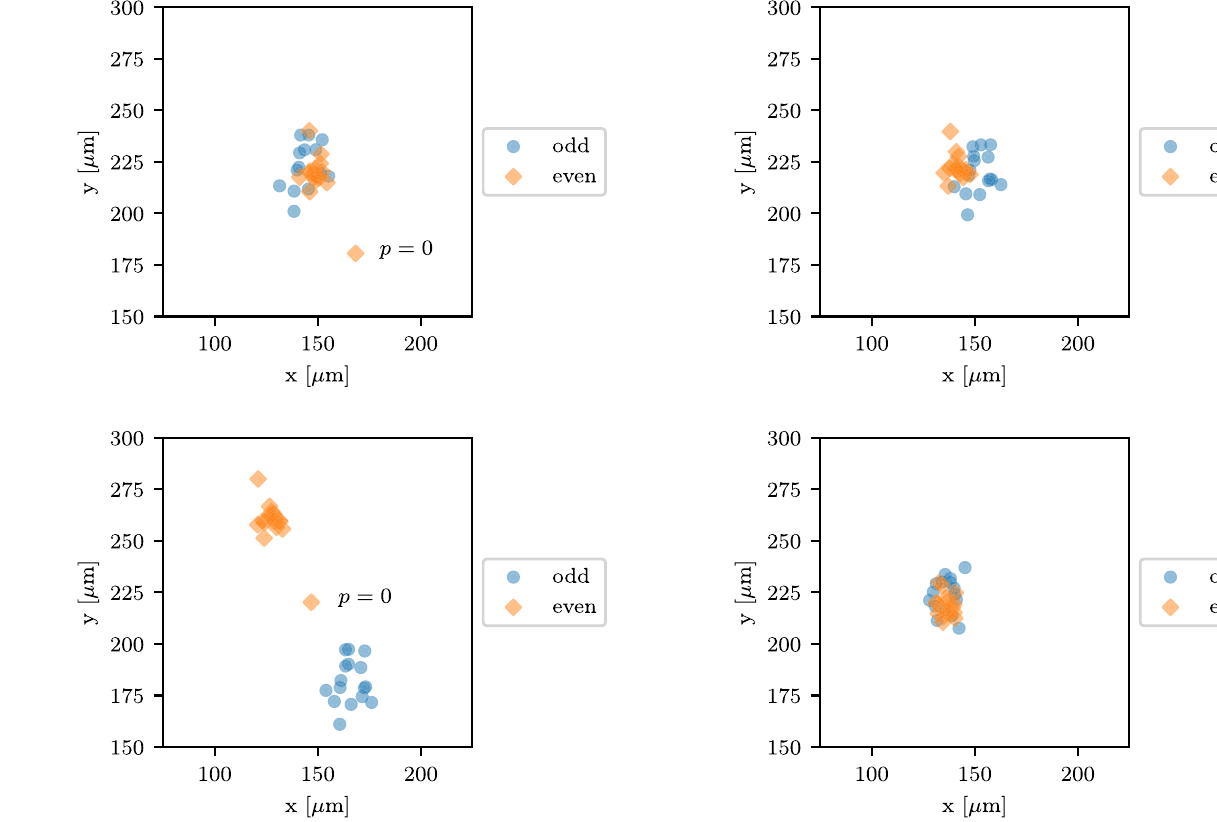
FIG. 28. Top: Experimental circulation pattern obtained after superposition of even and odd groups. Bottom: Experimental circulation pattern after injection steering the first pass p ¼ 0 at the IP position.